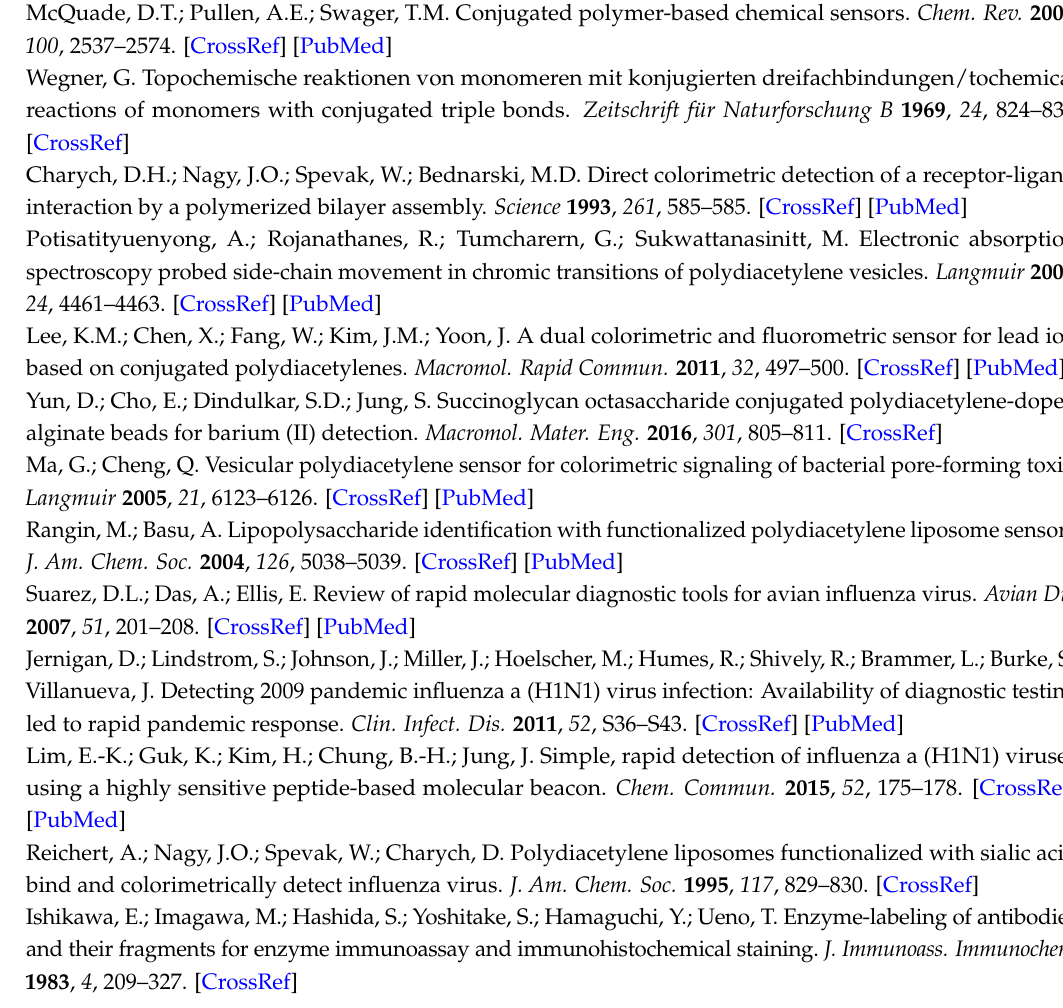
Figure S1: Colorimetric responses (%) for various antigen concentrations in the antibody-PDA conjugates and unfunctionalized PDA, Figure S2: DLS profile of non-modified PDA nano-vesicles (average diameter = 175 nm), Figure S3: FT-IR spectra of the original PVDF (blue line), buffer-treated antibody-PDA coated PVDF (purple line), BSA-treated antibody-PDA coated PVDF (green line), and virus antigen-treated antibody-PDA coated PVDF (red line), Table S1: FT-IR absorption bands of N-benzyltriazole derivatized dextran before and after